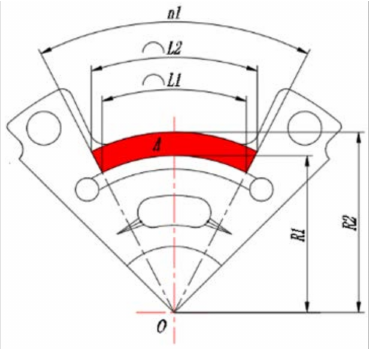
Figure 4. Schematic of mathematical model for region